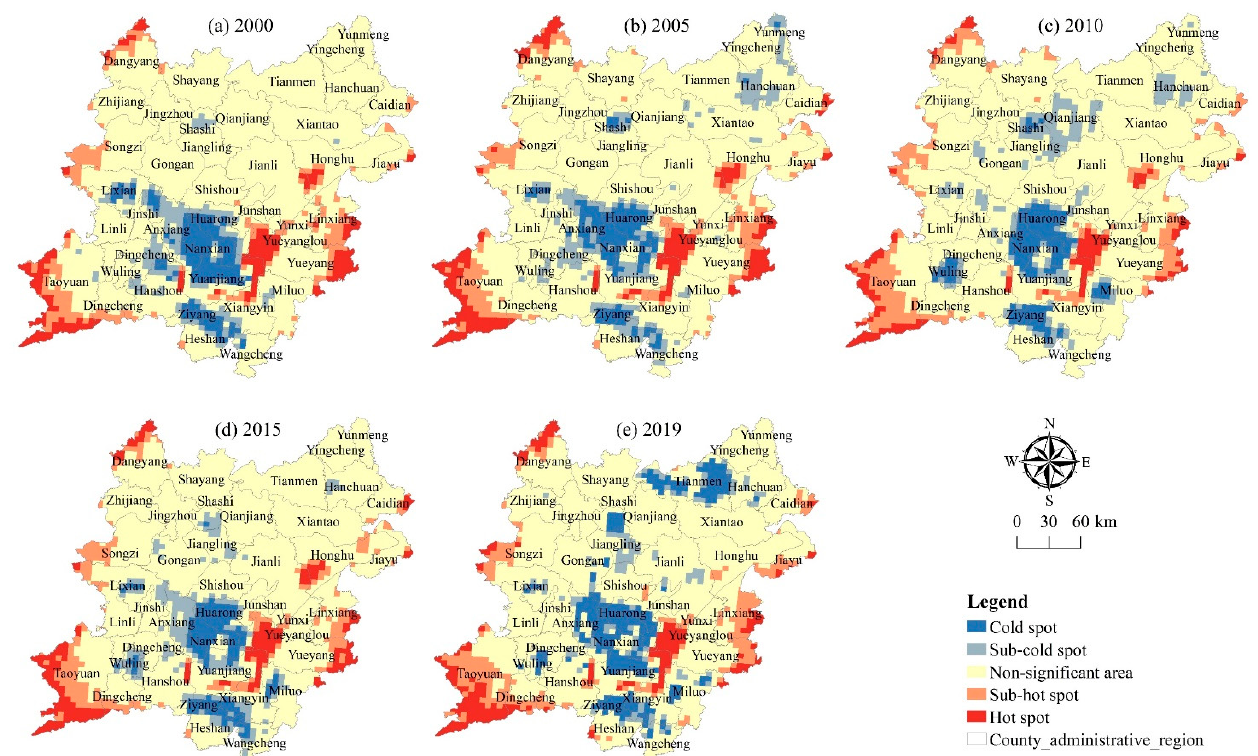
Figure 4. Spatial pattern of pressure index and cold hot spot of cultivated land system in the two lake plains from 2000 to 2019.